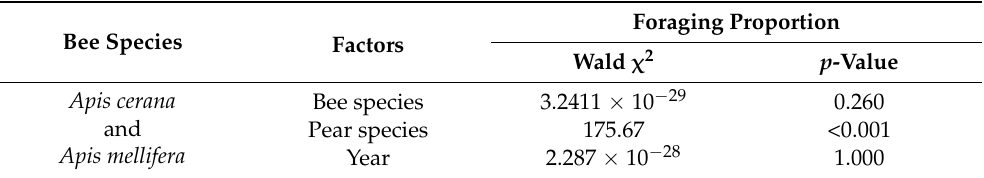
Table 1. Generalized linear model (calculated Wald χ 2 and p value) of the effect of bee species ( A. cerana and A. mellifera ), pear species ( P. bretschneideri and P. communis ) and year on single pear flower foraging proportion.